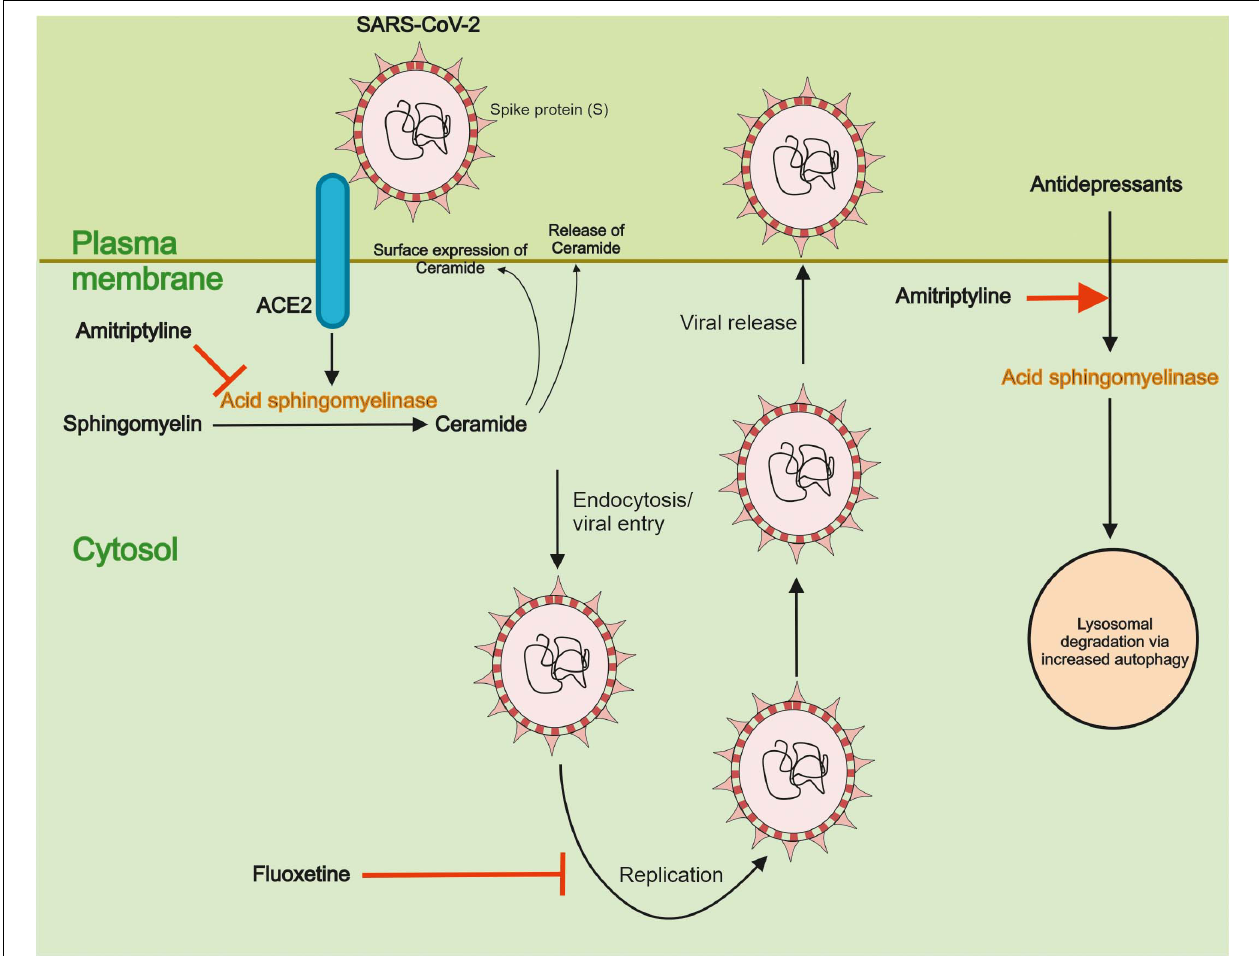
FIGURE 3 | Functional interactions between SARS-CoV-2 and the ASM/ceramide system. Effects of antidepressant drugs. Ceramide plays an important role in signaling by different cell surface receptors. Ceramide is produced from sphingomyelin by the action of Acid sphingomyelinase (ASM) in lysosomes and cell membranes. It was recently shown that the interaction of SARS-CoV-2 with ACE2 activates ASM in cells and induce an accumulation of ceramide at the cell surface. The antidepressant drug Amitriptyline reduced ASM levels and activity, and the production and accumulation of ceramide. This in turn diminished the uptake of SARS-CoV-2 in human epithelial cells. Amitriptyline further prevented the infection of nasal epithelia cells by SARS-CoV-2 in an ex vivo model using human volunteers (see text for details). The antidepressants act by functionally inhibiting ASM and reducing ceramide levels in membranes and they are also known to influence autophagy. Fluoxetine was further shown to inhibit the SARS-CoV-2 replication through effects on endolysosome acidification and cholesterol levels. More detail studies are, however, warranted for how different antidepressants and other drugs may affect the viral uptake, replication and the other intracellular steps in the life cycle of SARS-CoV-2. Likewise, clinical studies are important to conduct with the antidepressant and other promising drugs with regard to their potential use and safety for treatment of patients afflicted by